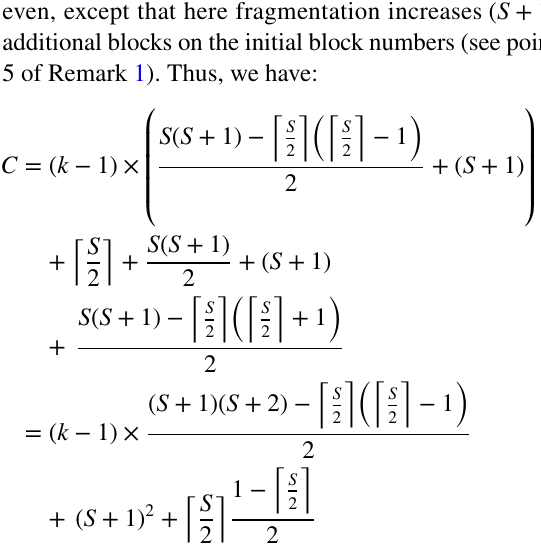
Fig. 6 Partitioning for n = 31 , k = 2 and p ∈ { 2,3,4